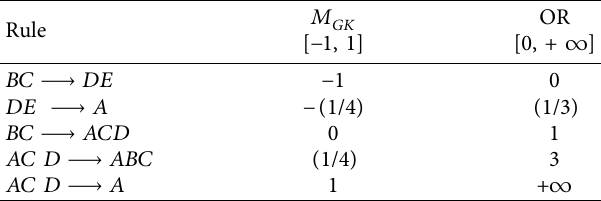
Table 3: The values taken for the quality measures M some of the association rules considered.